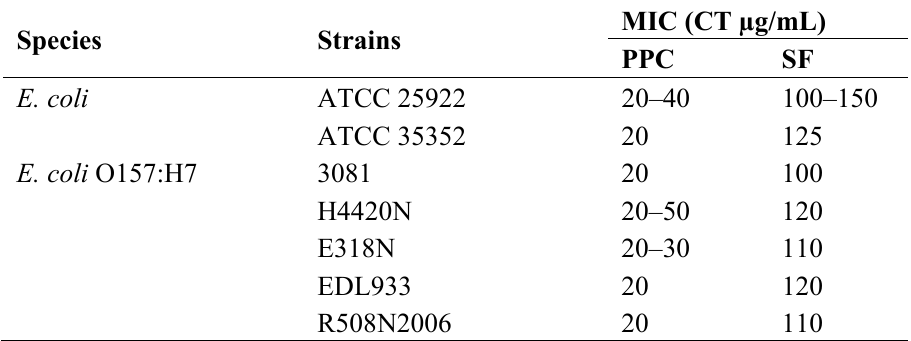
Table 3. Minimum inhibitory concentration (MIC) of condensed tannins (CT) of purple prairie clover (PPC; Dalea purpurea Vent.) and sainfoin (SF; Onobrychis viciifolia ) to Escherichia coli and E. coli O157:H7.